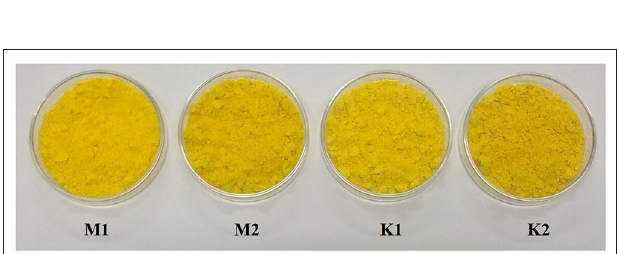
FIGURE 4 | Physical aspect of buriti oil microcapsules stabilized with: mung bean flour equivalent to 1% (w w − 1 ) of protein (M1); mung bean flour equivalent to 2% (w w − 1 ) of protein (M2); red kidney bean flour equivalent to 1% (w w − 1 ) of protein (K1); red kidney bean flour equivalent to 2% (w w − 1 ) of protein (K2) in the